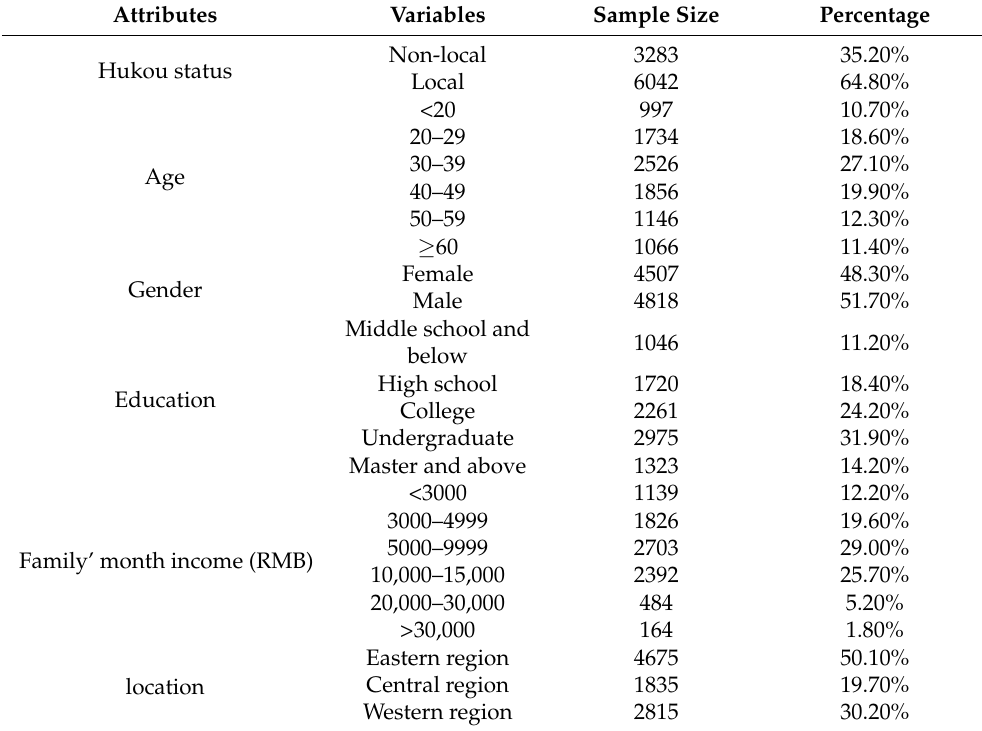
Table A1. Socioeconomic characteristics of the study